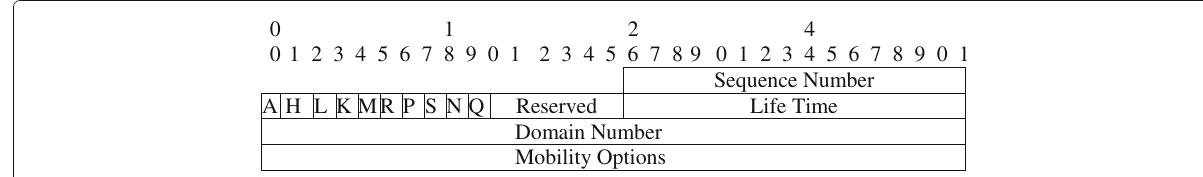
Fig. 8 PBA message, including the domain number